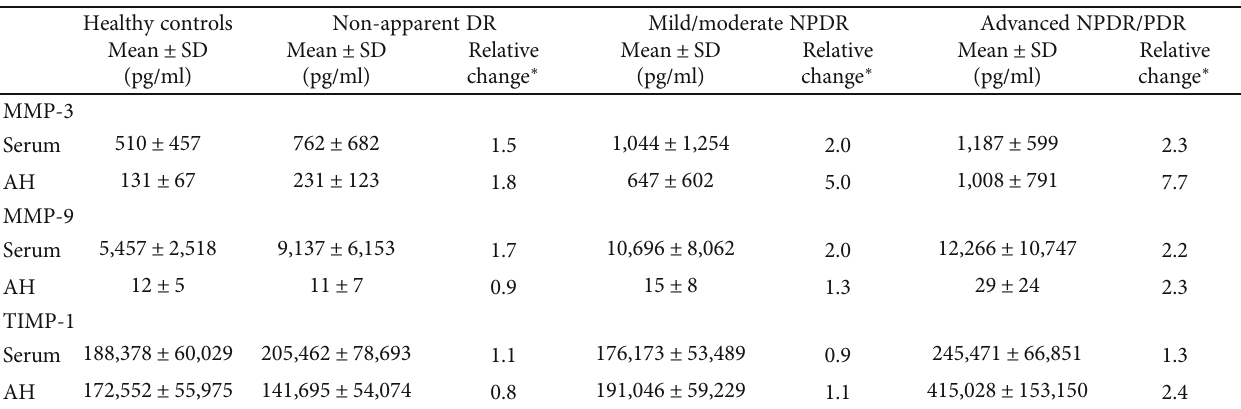
Table 4: Concentrations ( mean ± SD ; pg/ml) of MMP-3, MMP-9, and TIMP-1 in serum and AH of healthy individuals (controls) and diabetic patients with di ff erent stages of DR. The fold change for each group was calculated relative to the control